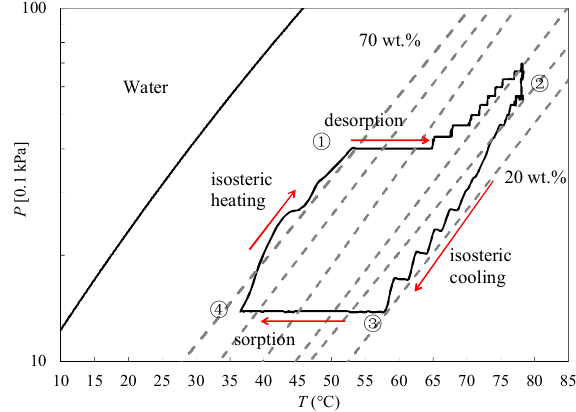
Figure 4. Typical experimental test on the WSS + 40 wt. % LiCl coated corrugated heat exchanger in the Clapeyron diagram.